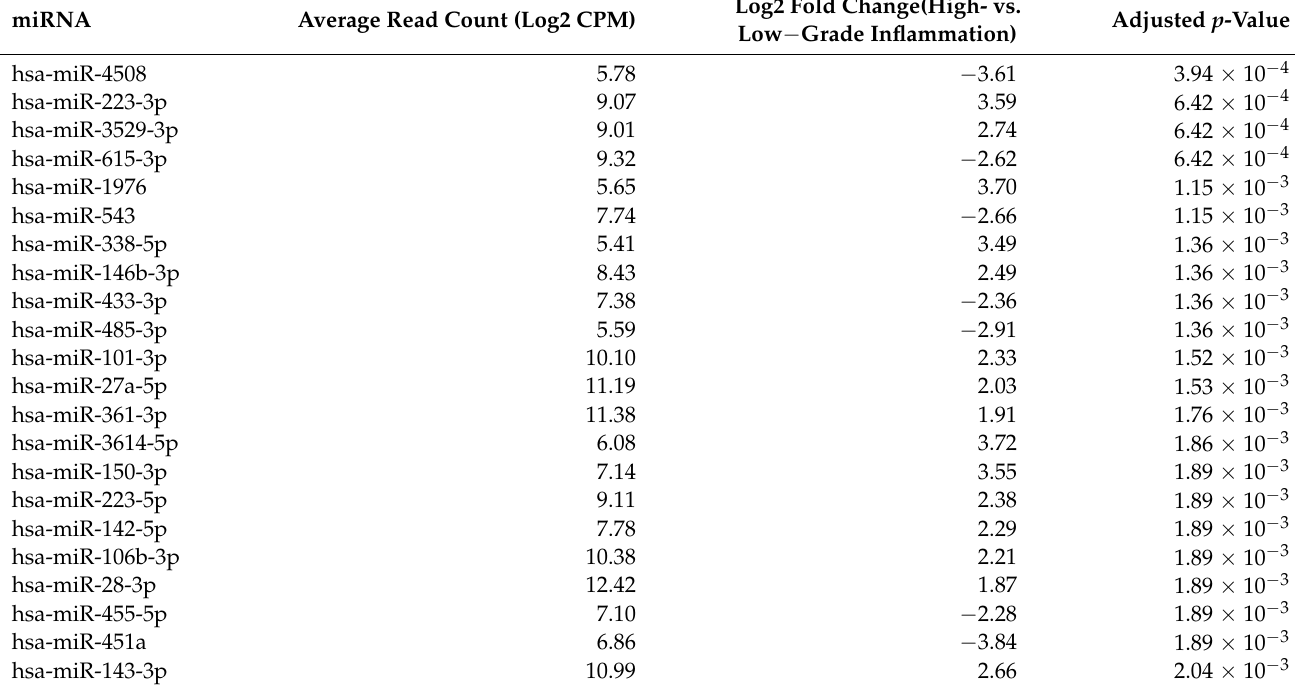
Table 4. Differentially expressed